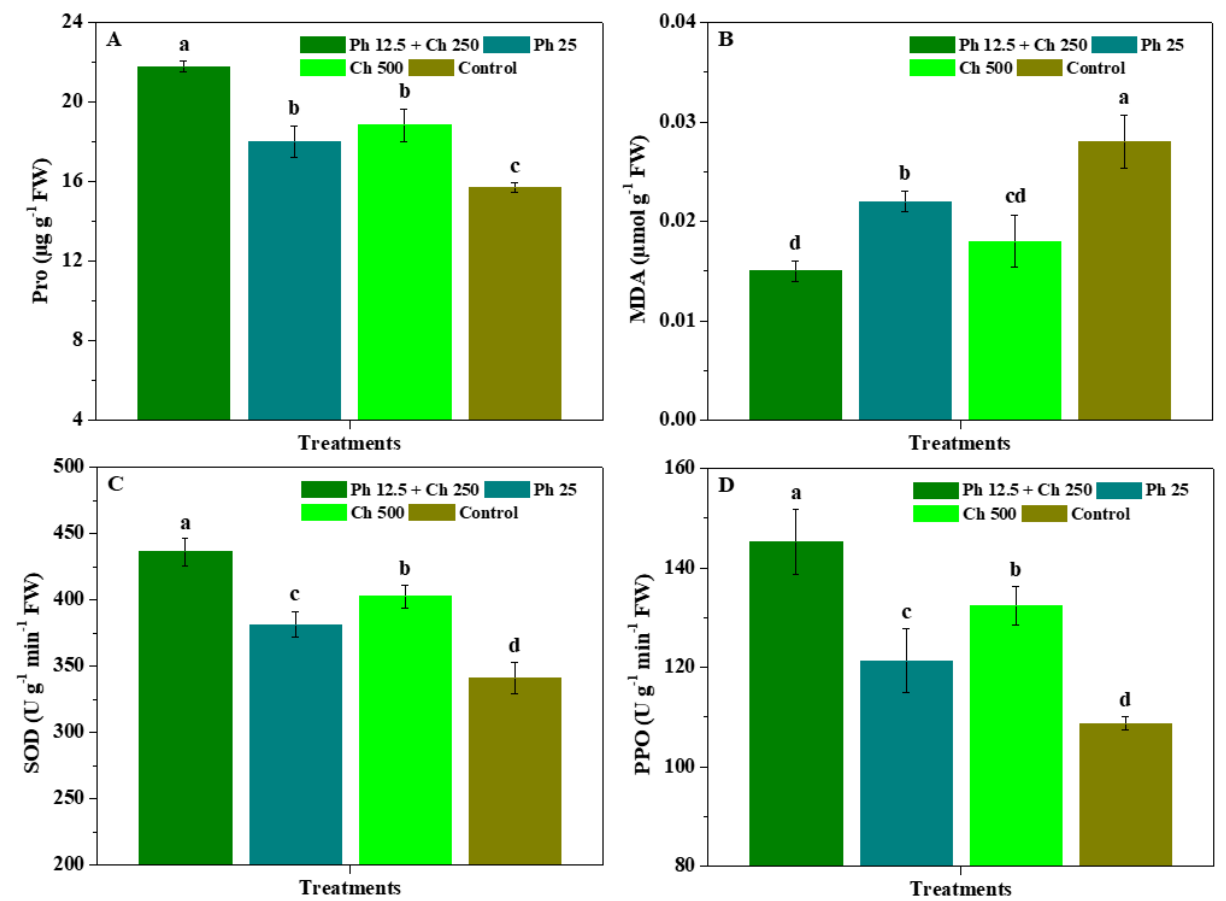
Figure 2. The impacts of physcion + chitosan, physcion, and chitosan on the Pro ( A ), MDA ( B ), SOD activity ( C ), and PPO activity ( D ) of leaves. The significant differences in the five treatments at 5% ( p < 0.05) level are stood by different letters. Error bar represents the SD of three duplicates.